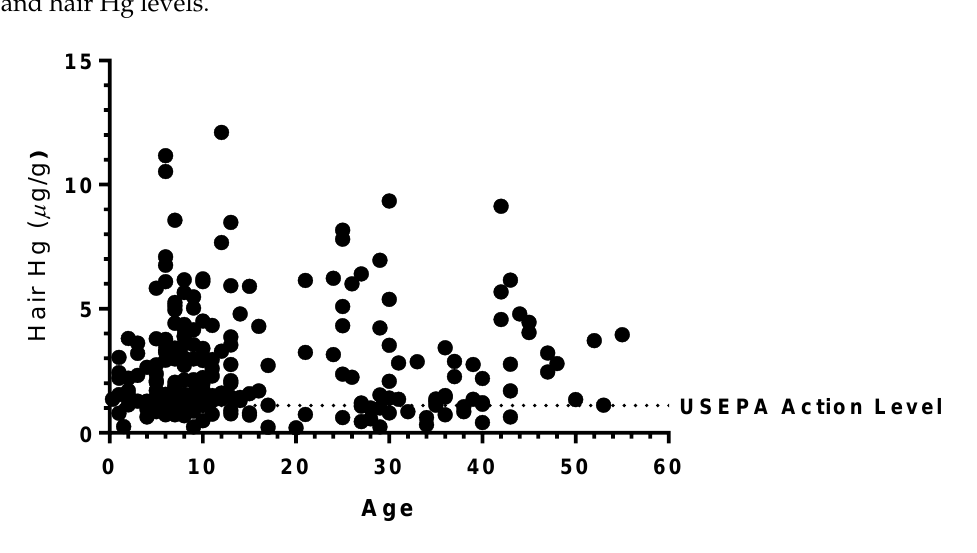
Figure 4. Scatterplot representing levels of mercury in hair of research participants and age. The USEPA action level of 1.1 µg/g is plotted for comparison. No significant correlation exists between hair mercury levels and age.